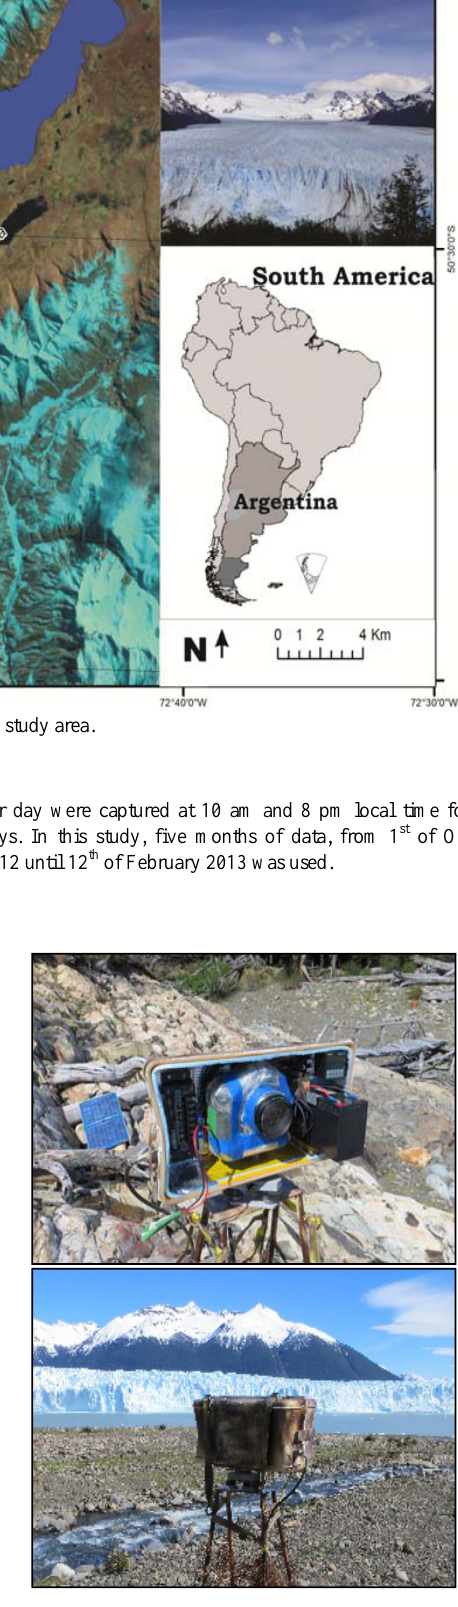
Figure 2. Systems and components of the